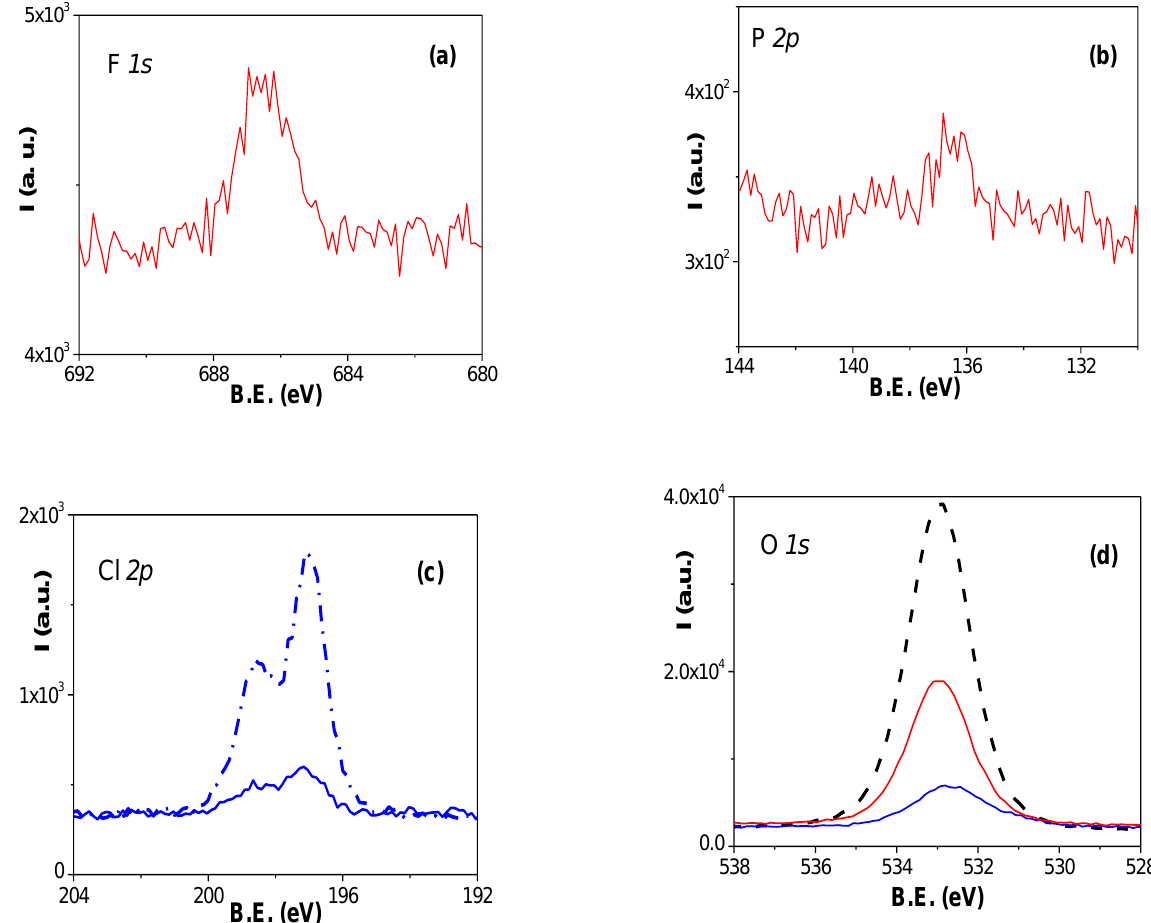
Figure 2. ( a ) Fluorine and ( b ) phosphorous core level signals for the RC/BMIMPF 6 film. ( c ) Com- parison of chlorine signals for the RC/AliquatCl film (blue solid line) and the AliquatCl IL (blue dashed–dot line. ( d ) Oxygen core level signals for the RC/BMIMPF 6 film (red solid line), the RC/AliquatCl film (blue solid line) and the RC-support (black dashed line).